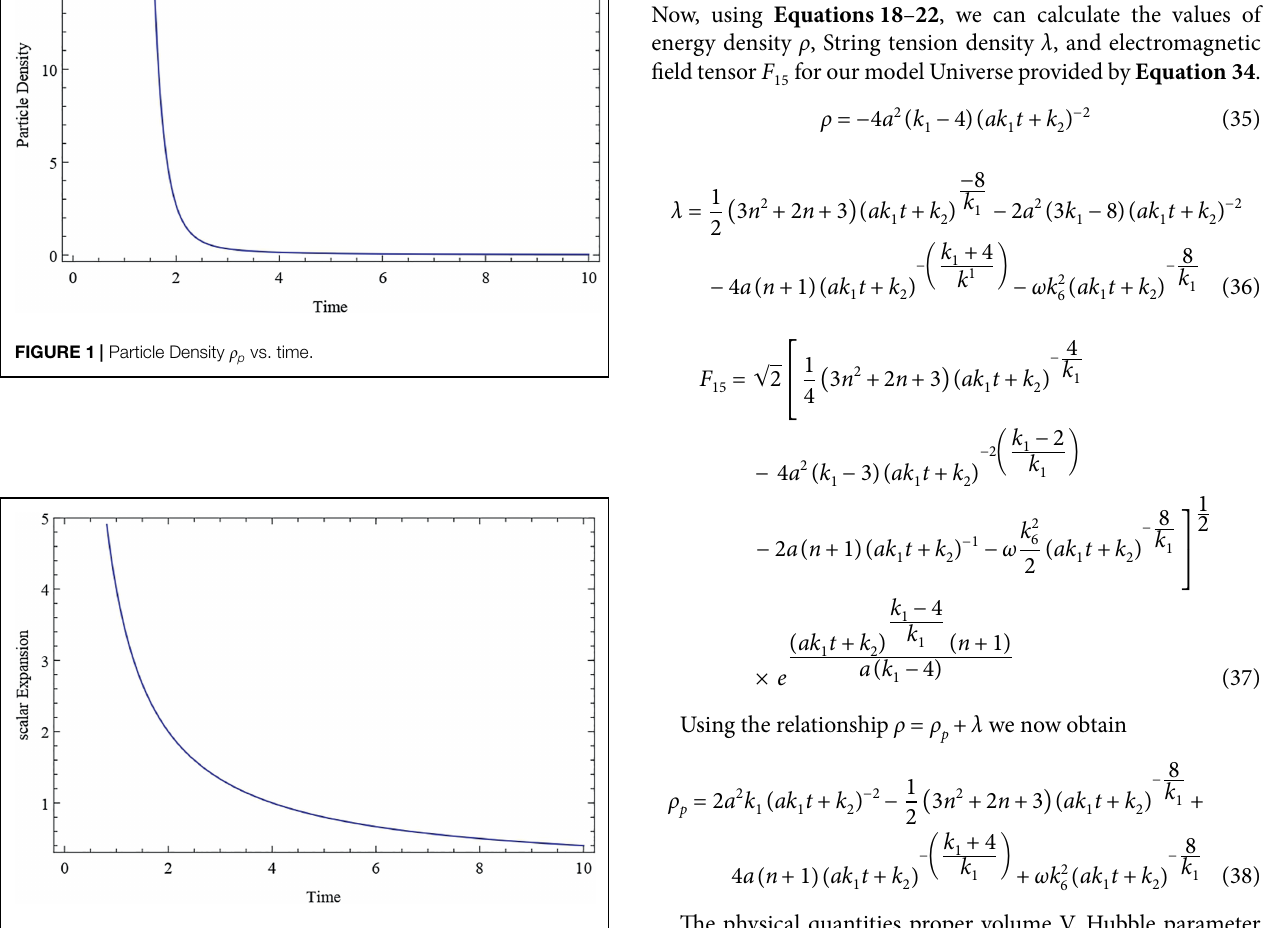
FIGURE 2 | Scalar Expansion θ vs. time.